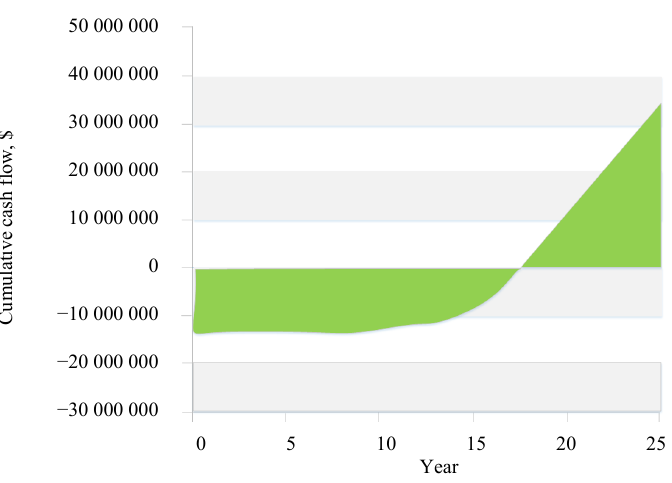
Fig. 4 Cumulative cash flow – Single axis tracker.